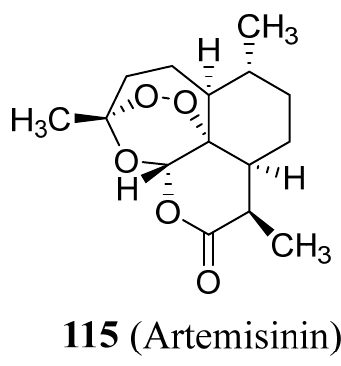
Figure 9. Artemisinin, antimalarial drug.